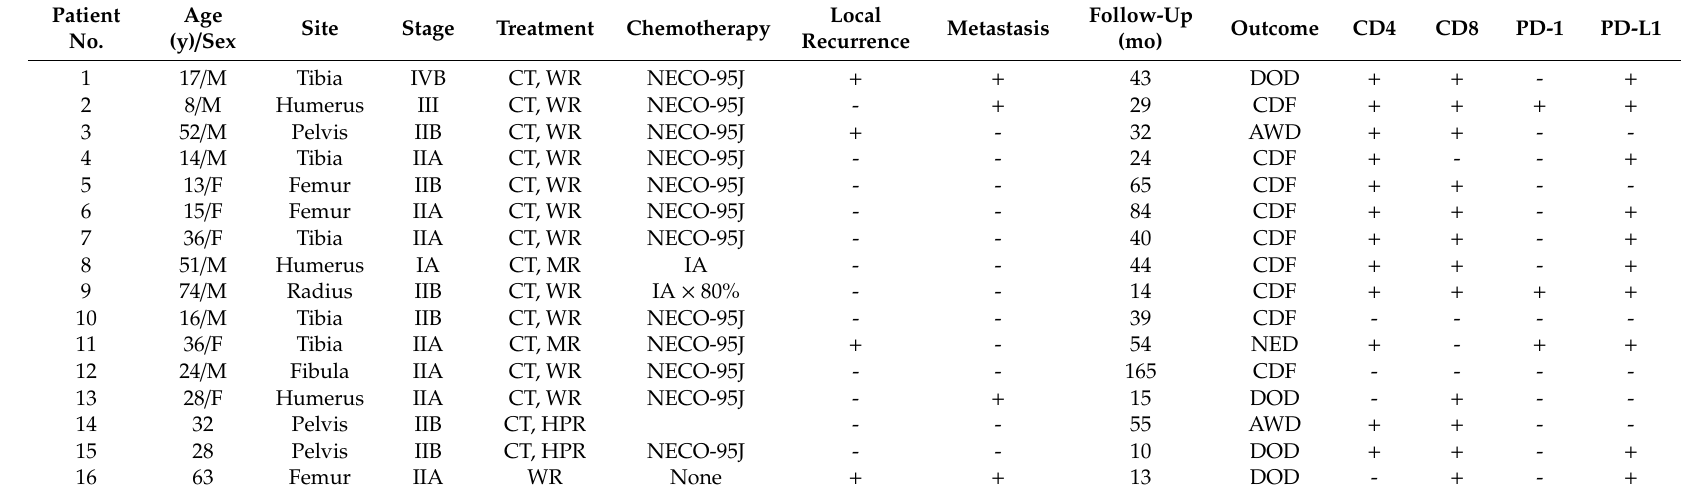
Table 1. Clinical features of patients with primary osteosarcoma treated at our hospital and immunopositivity for CD4, CD8, PD-1, and